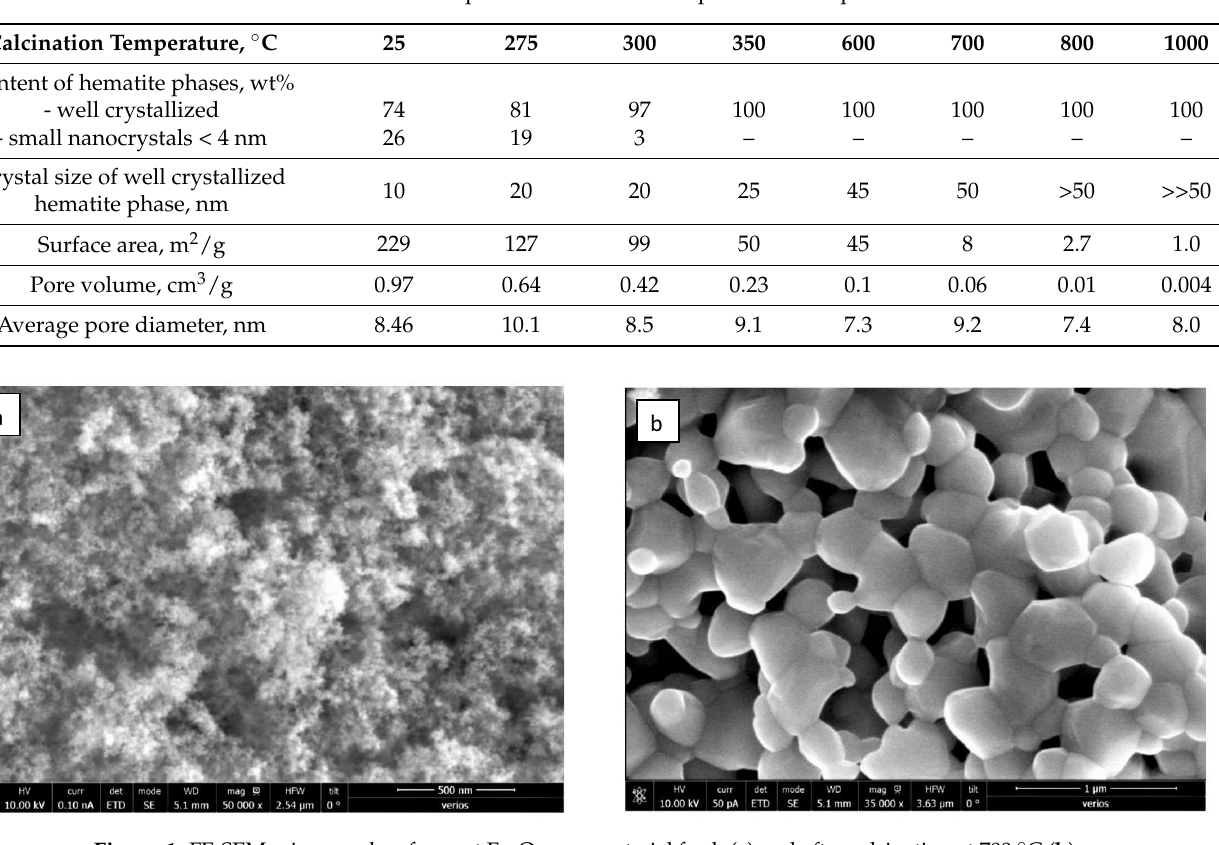
Figure 1. FE-SEM micrographs of parent Fe 2 O 3 core material fresh ( a ) and after calcination at 700 ◦ C ( b ). In nanocrystalline iron oxide, small crystals disappeared at temperatures > 300 ◦ C.